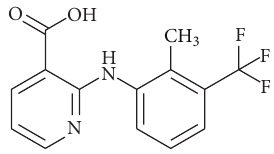
Scheme 1: Structure of